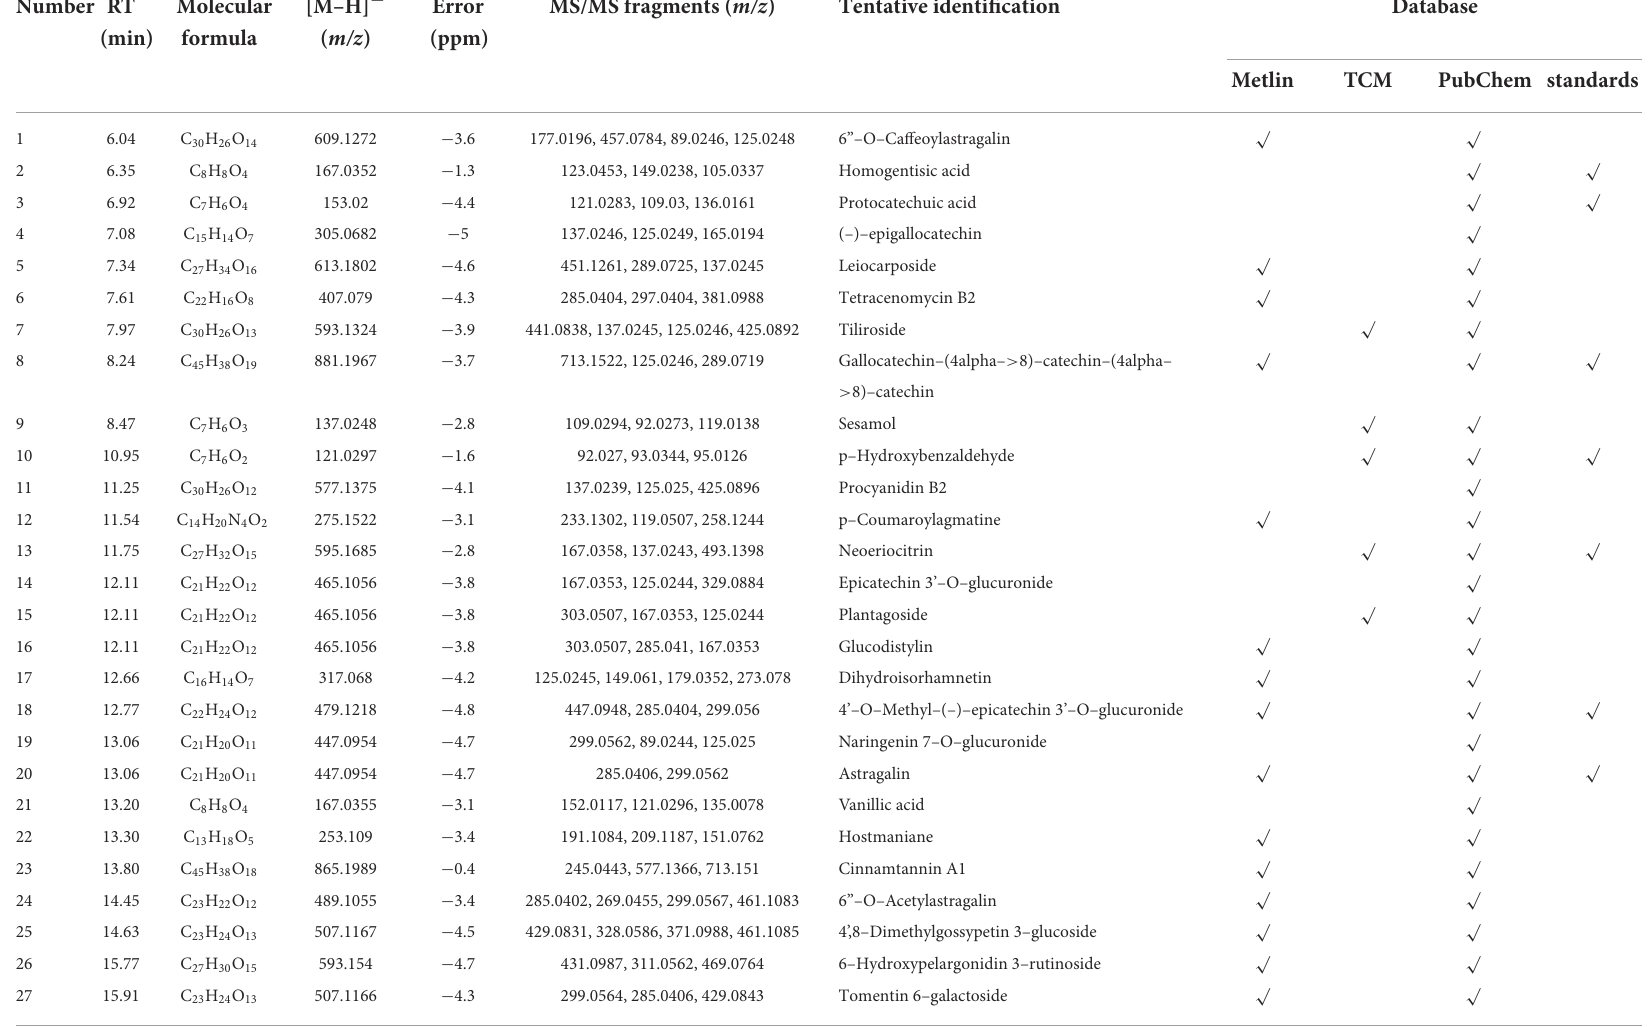
TABLE 2 Phenolic compounds identified in HBP extract by